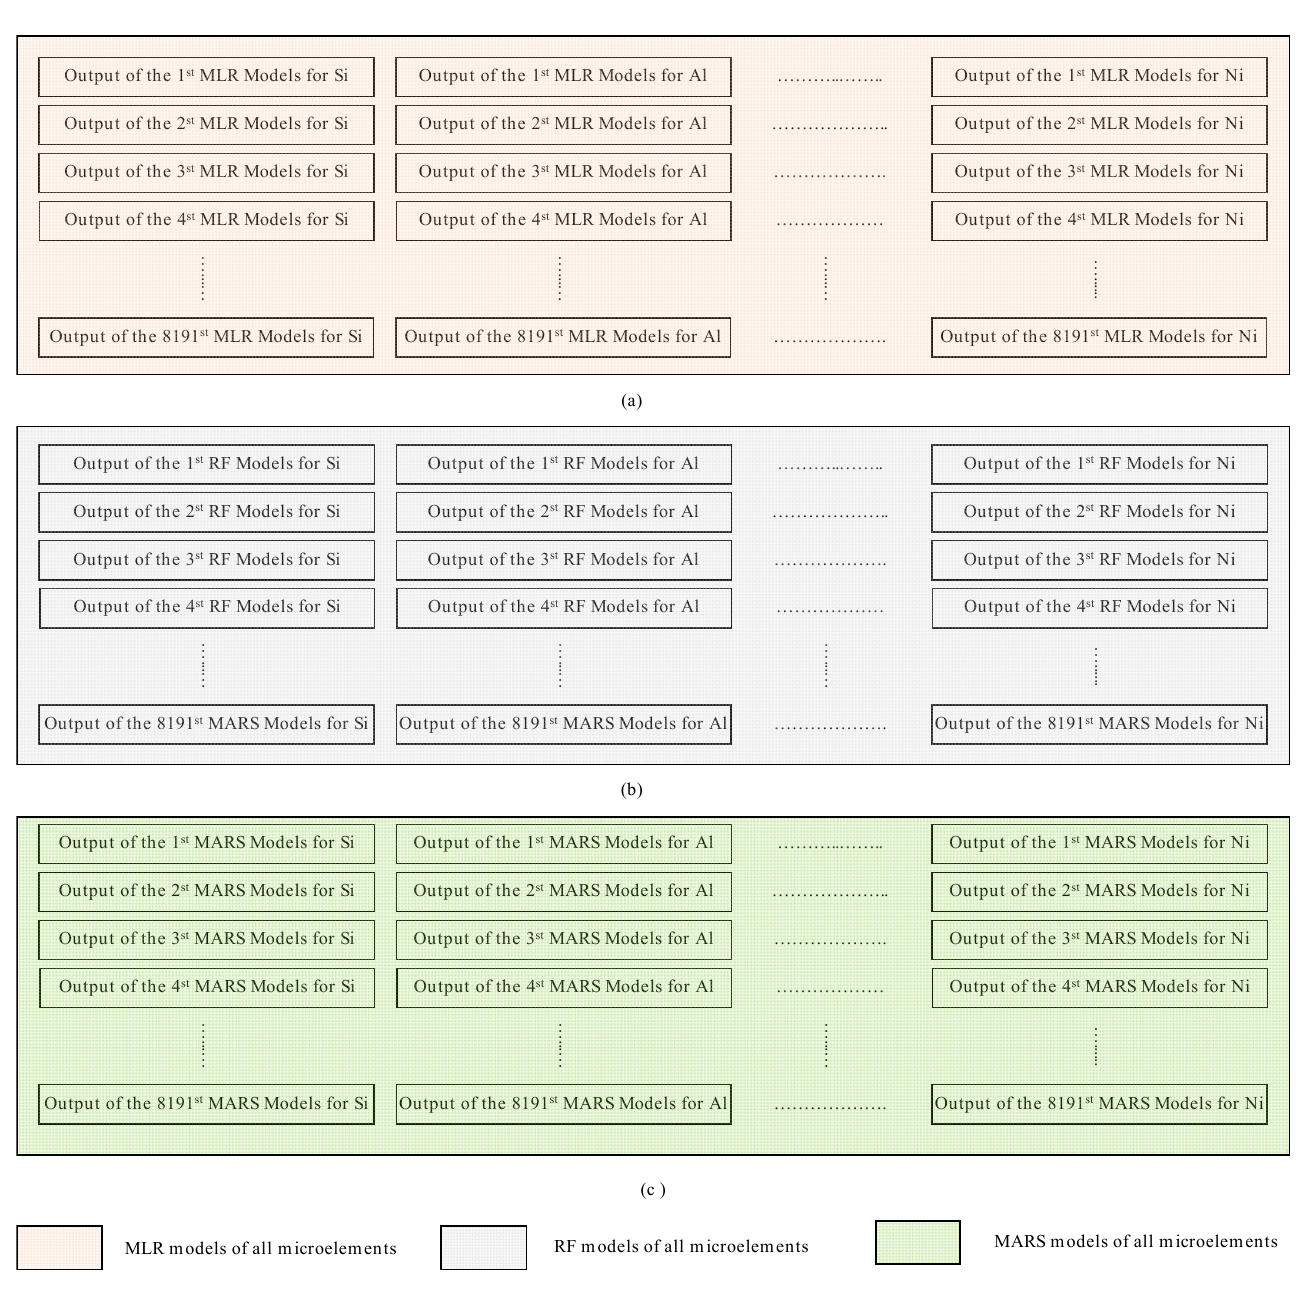
Figure 3. The method used to construct the outputs from the three different models used in this study (MLR, RF, and MARS) ( a ) models generated using MLR, ( b ) models generated using RF, ( c ) models generated using MARS.